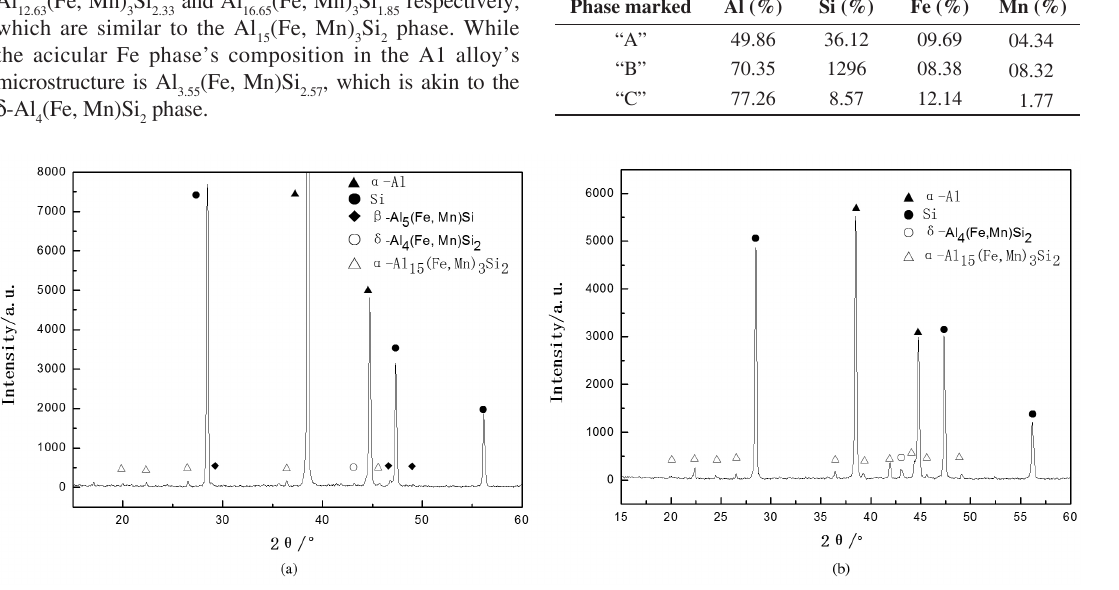
Figure 5. (a) XRD spectra of CS-cast A1 alloy; (b) XRD spectra of CS-cast A2 alloy.